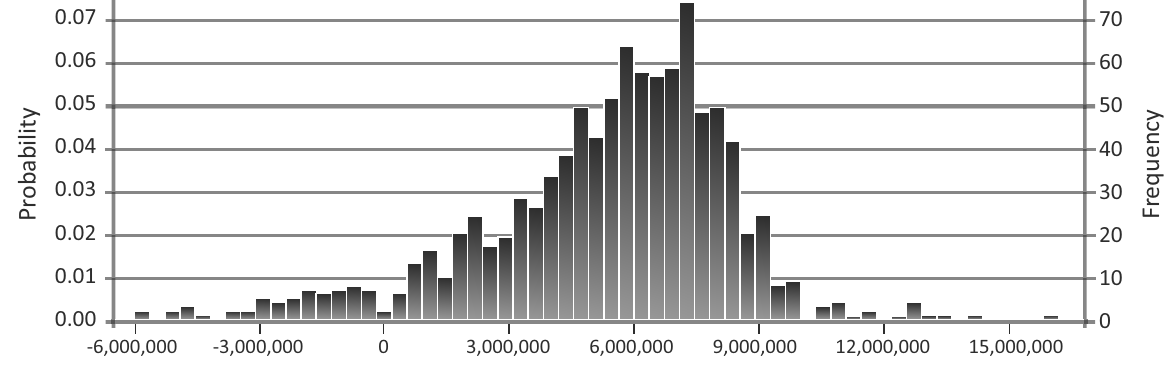
Figure 1. Probability distribution of the resulting value of the company –